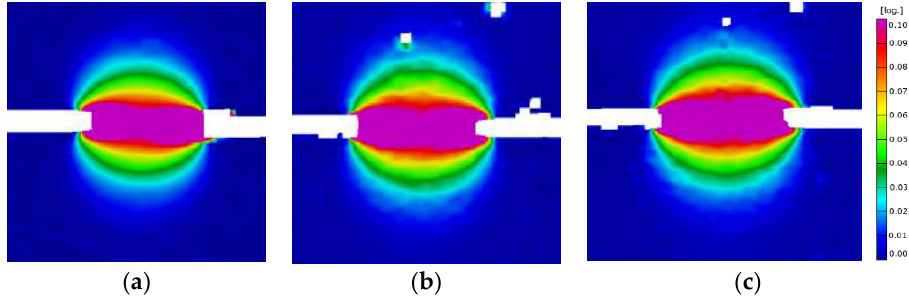
Figure 9. Von-Mises strain around the ligament at different stages during EWF testing for a ligament length of 7.89 mm: ( a ) 50 s; ( b ) 70 s; ( c ) 98 s.